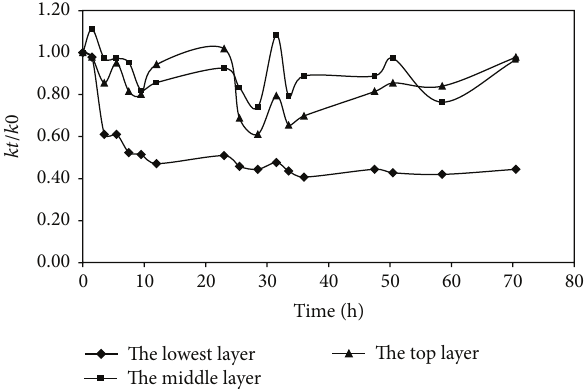
Figure 14: Relationship between 𝑘𝑡/𝑘0 and time in the lowest layers under different hydraulic